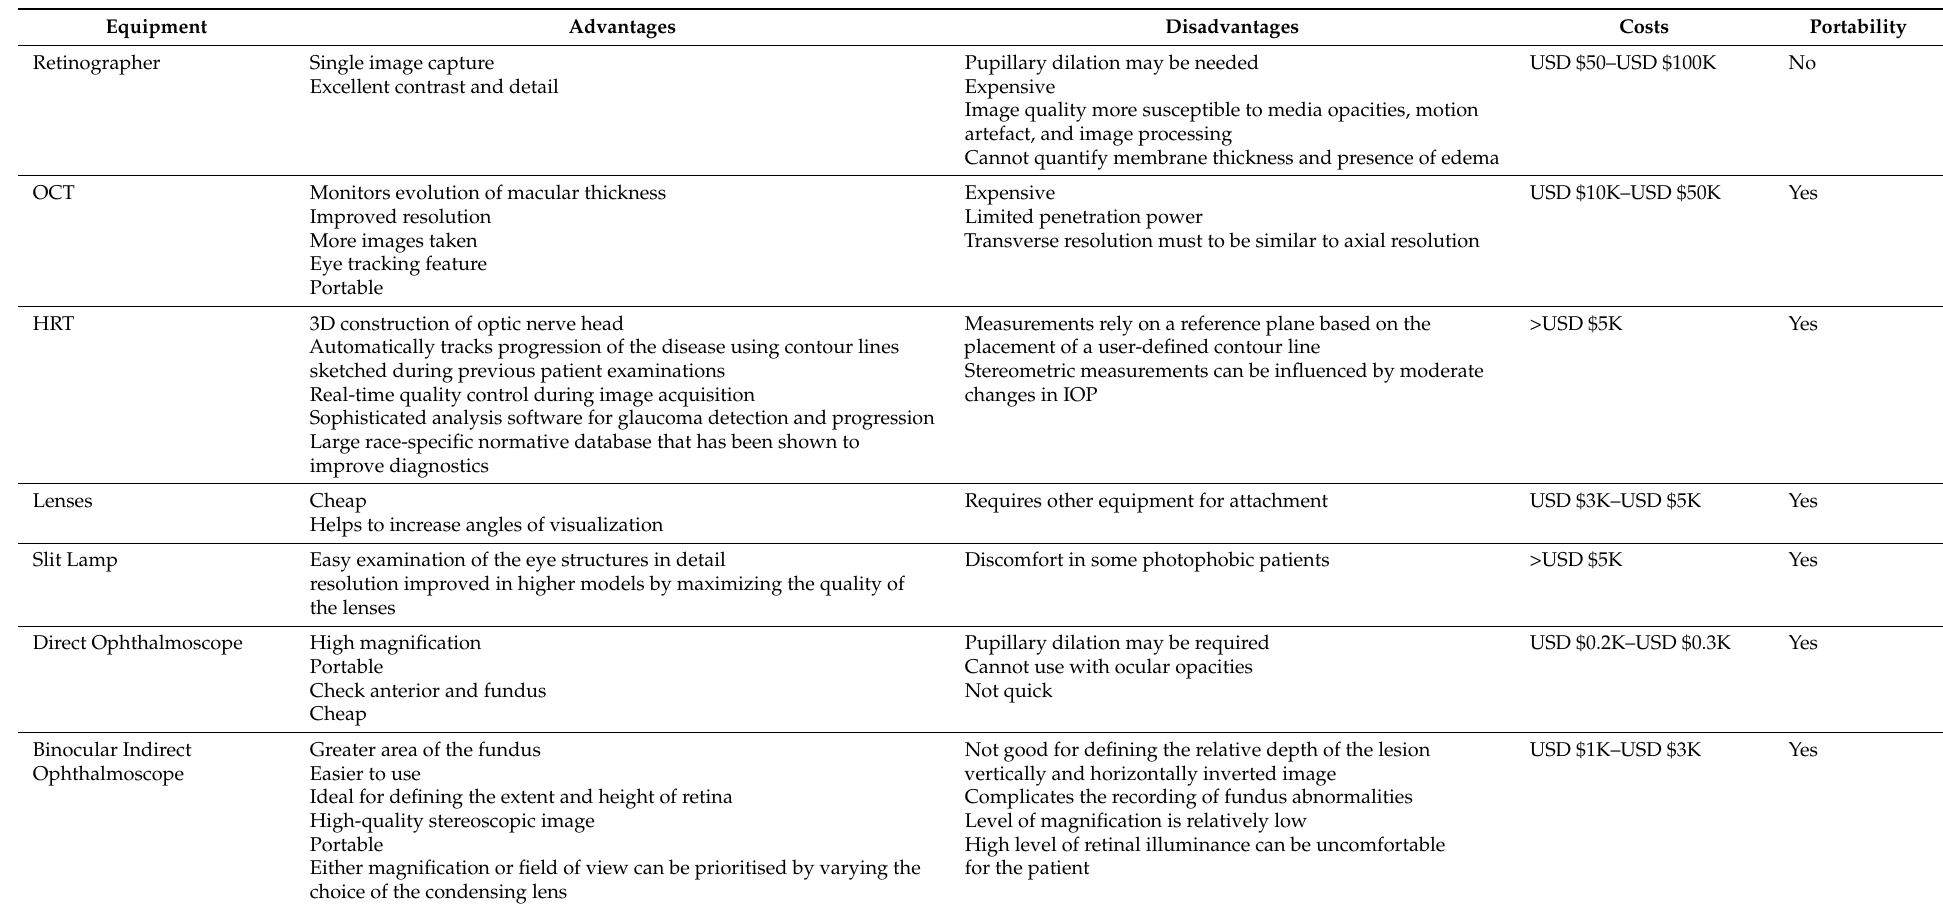
Table 2. Summary of equipment advantages, disadvantages, costs, and